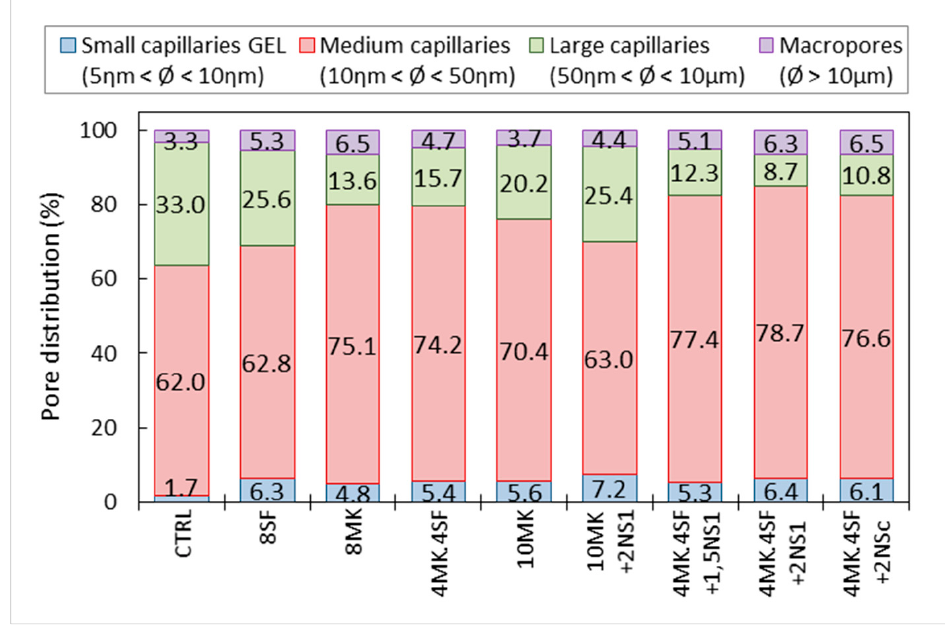
Figure 10. Curves of the thermogravimetric derivative according to temperature ranges.